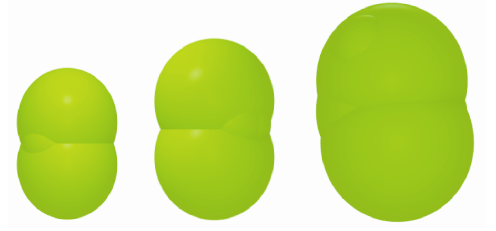
Fig. 3. Characteristic shapes of modeled particles Table 1. Parameters of created discrete models of particles Mass,